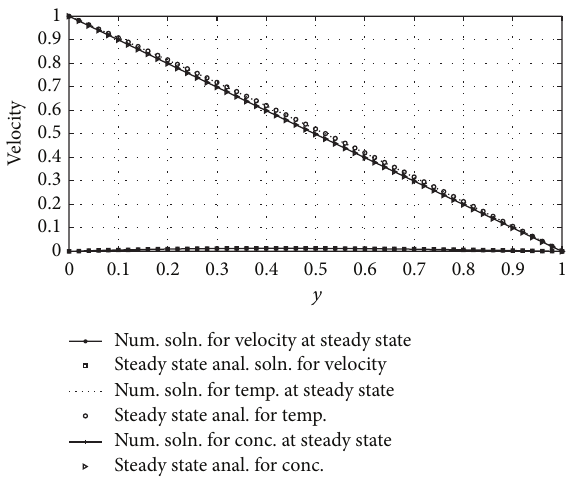
Figure 2: Unsteady and steady state solutions for velocity, tempera- ture, and concentration